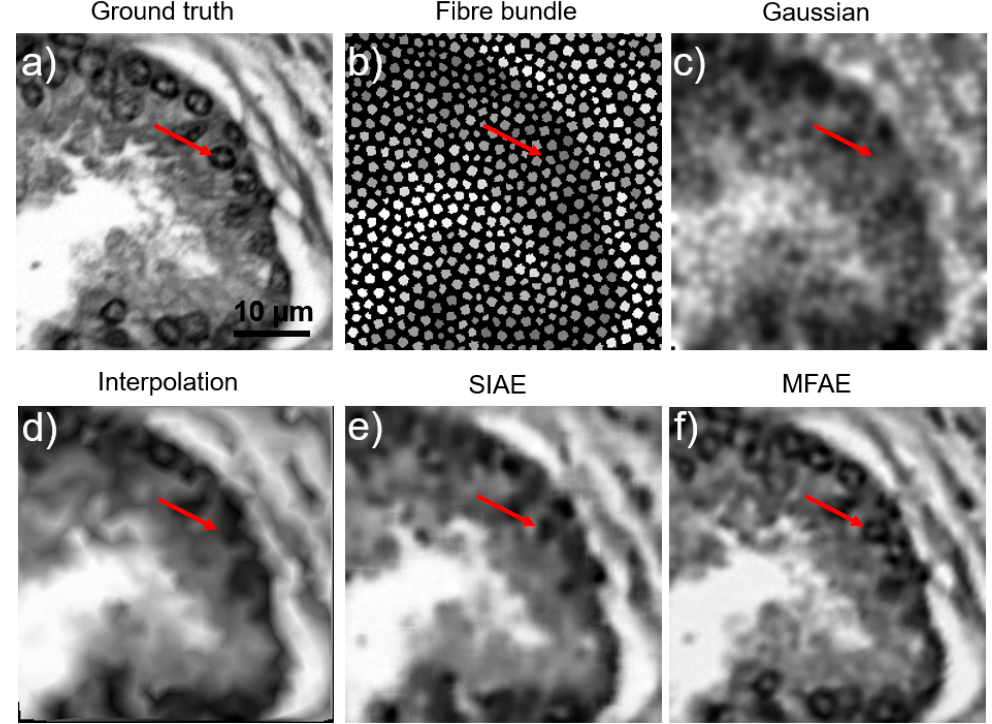
Figure 5. Reconstruction method comparison on acquired prostate images. ( a ) ground truth. ( b ) averaged fiber bundle. ( c ) gaussian blurring. ( d ) linear interpolation. ( e ) single-image autoencoder. ( f ) multi-frame autoencoder. Red arrows point to specific cell nuclei location across each image.